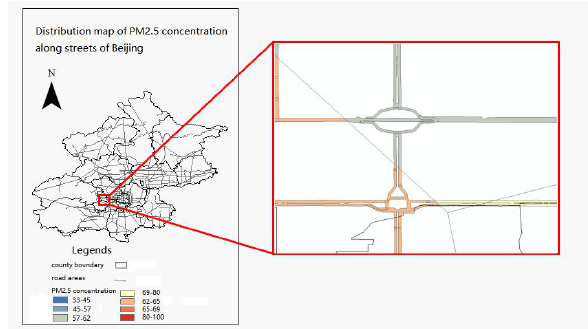
Figure 7. Predicted distribution of average PM2.5 concentration under the constraints of Beijing's road network It can be seen from the prediction results that under the constraints of the road network, the trend is high in the south and low in the north. The average concentration of pollutants in the southern part of Beijing is the highest, and the pollutant concentration in the northern part is the lowest, decreasing in a step-like manner from south to north. After the road network is weighted, it can be refined to the distribution of streets. The concentration of each street is different. In areas with high concentrations, there will be streets with lower